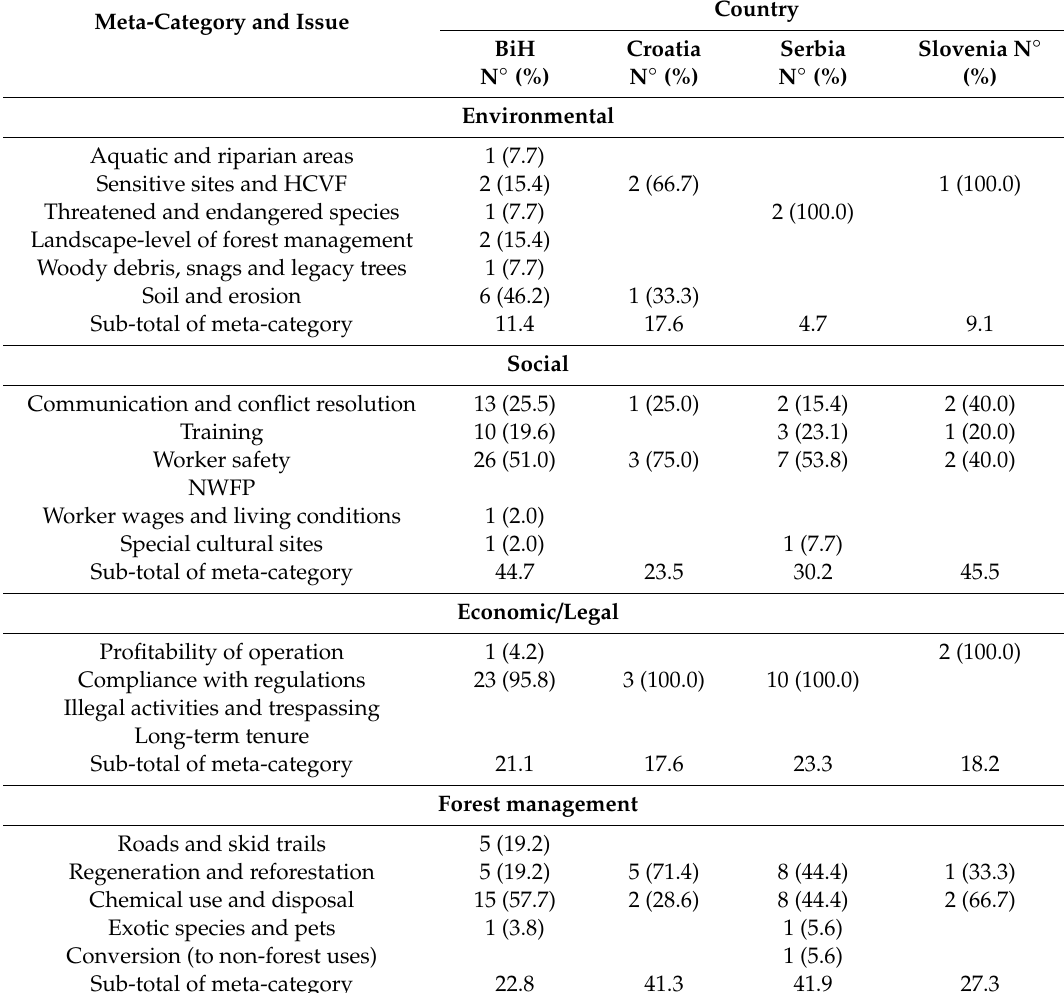
Table A4. Number of non-conformities by meta-categories and issues by